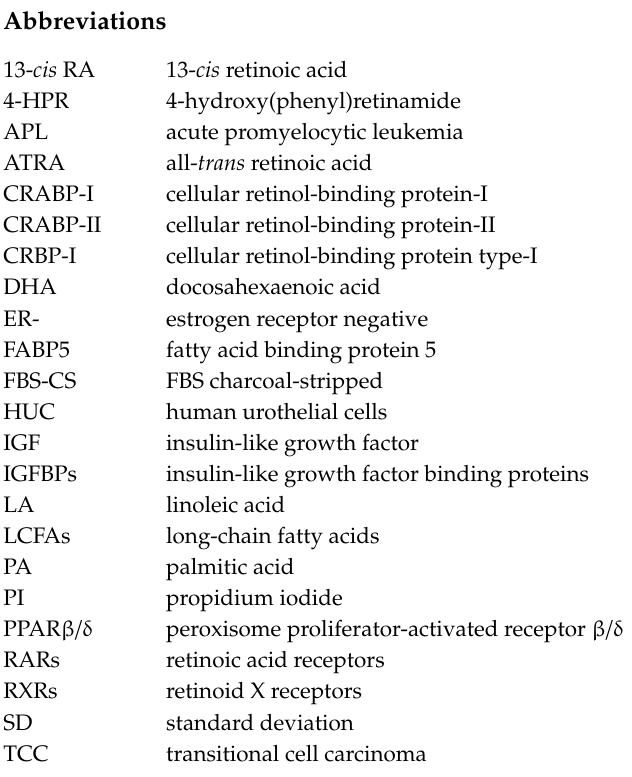
Figure S1: Absolute cell count made through flow-cytometry of T24 cells DMSO- and 10 µ M ATRA-treated at 72 h, Figure S2: 2-DE Proteomic profiling of T24 cell line after 10 µ M ATRA treatment, Figure S3: T24 are resistant to ATRA treatment but not to 4-HRP, synthetic retinoid, Figure S4: CRABP-II and FABP5 proteins’ expression in total healthy bladder lysate, Figure S5: T24 are resistant to PPAR β / δ antagonists, GSK0660 and PTS-58, alone or in combination to ATRA, Table S1: List of di ff erentially abundant proteins identified by LC-MS / MS T24 cells DMSO and 10 µ M ATRA treated for three